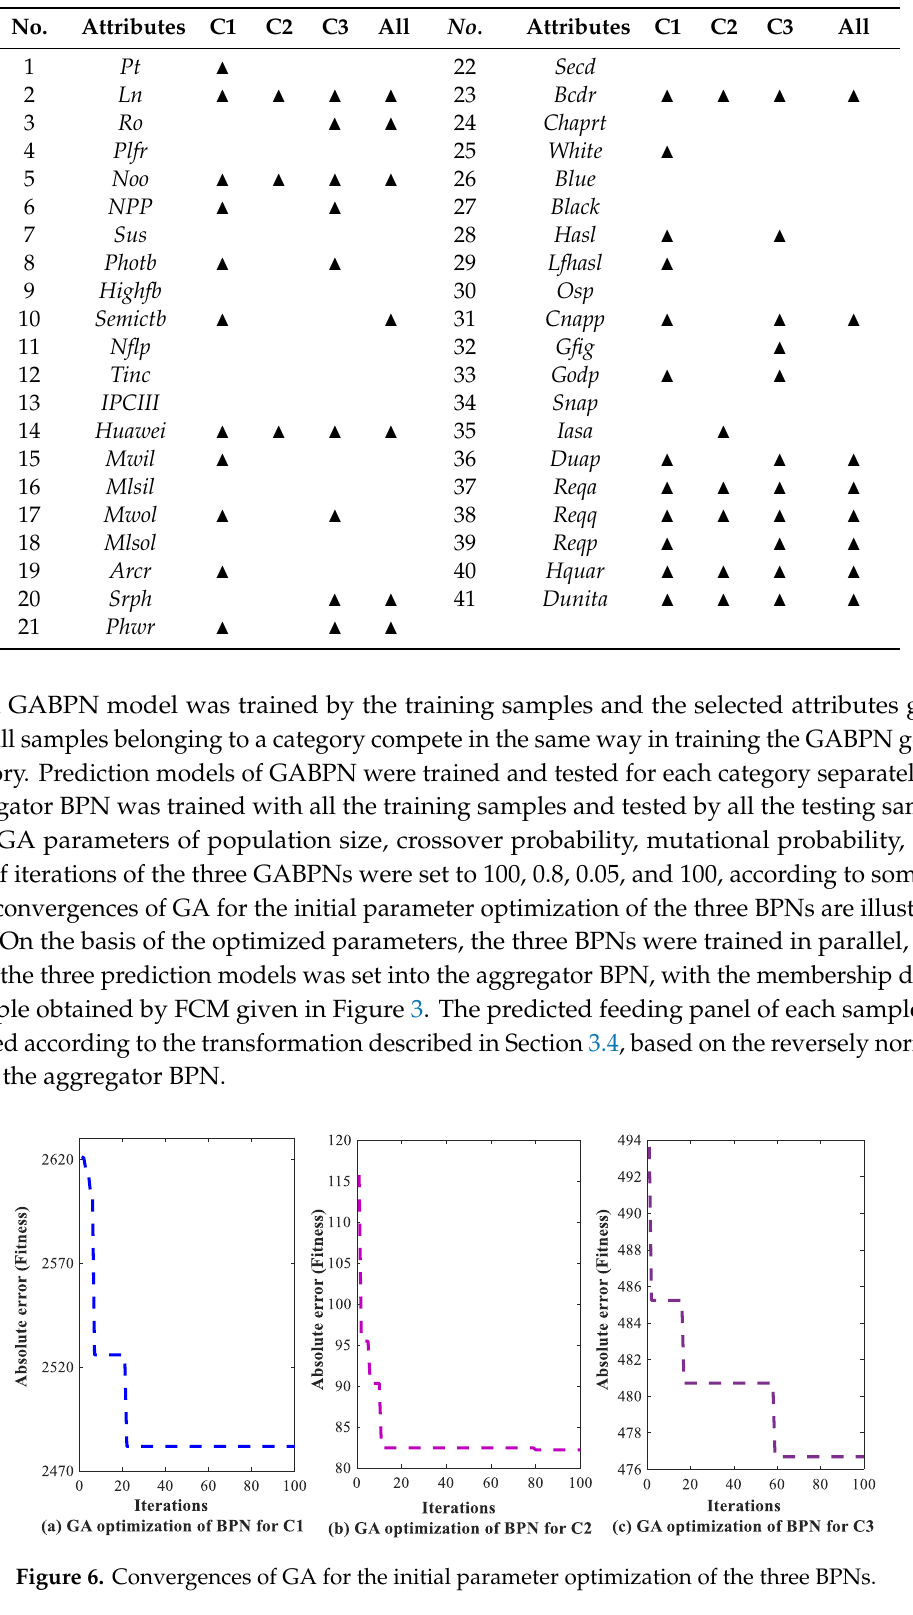
Figure 7. Regression of predicted feeding panel versus least feeding panel. The FCM–BPBPN was compared to manual feeding, BPN, MSC–ANN, FCM–GABPN without aggregation (indicated with FCM–GABPN w/o aggregation), and FCM–BPN five approaches to quantify its performance. Manual feeding is to determine the feeding panel for each template based on worker in PCB factory. BPN is to establish a single BPN prediction model without